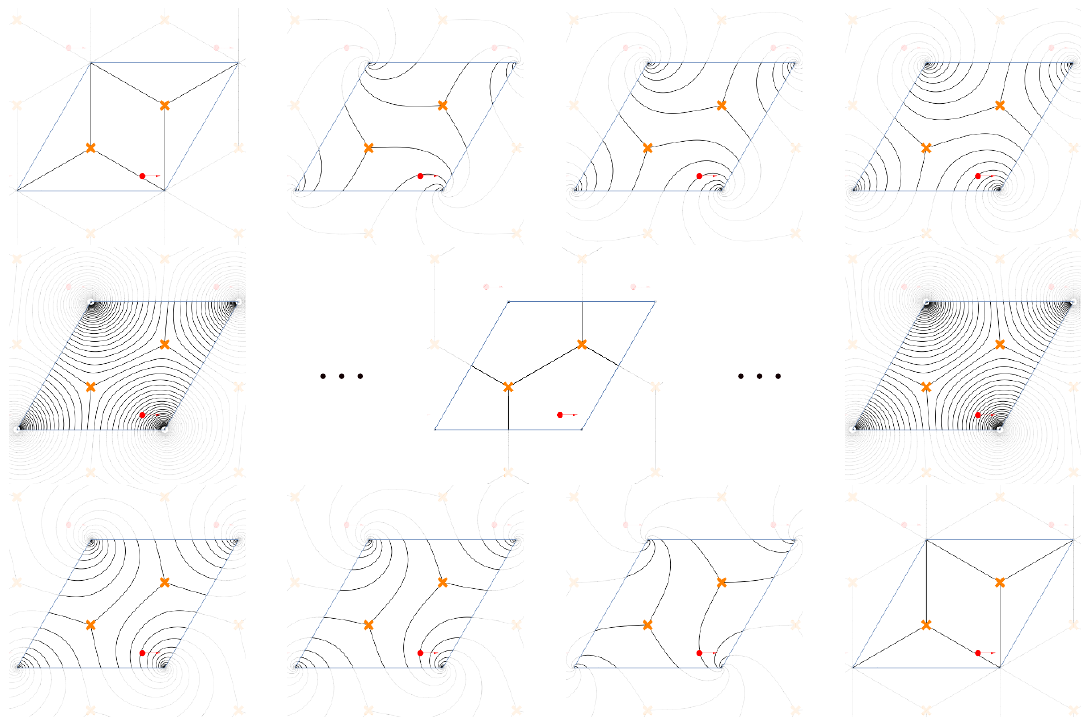
Figure 14. Sequence of spectral networks of the SU(2), N = 2 (cid:3) theory. The phases begin with sector I as described in (3.22), for phases ranging from # c (cid:0) (cid:25)= 2 (top-left) up to # c (center), and pro- ceeds with phases from sector II as described in (3.25) ranging from # c to # c + (cid:25)= 2 (bottom-right).